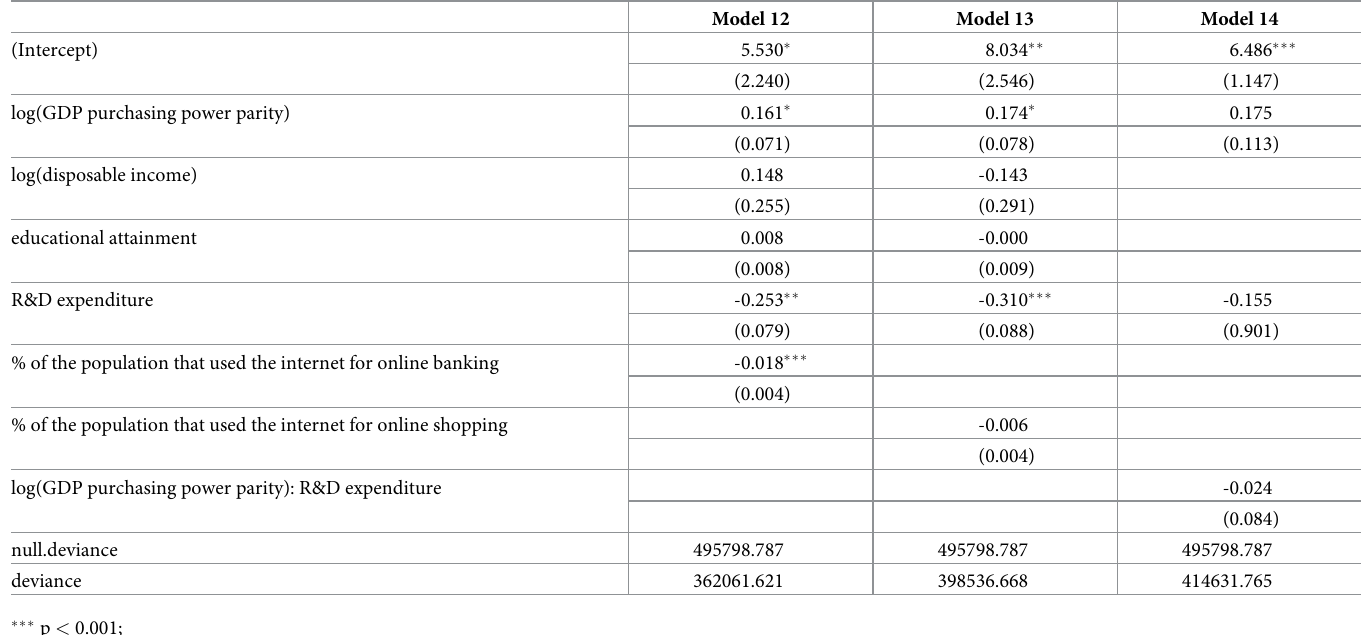
Table 8. European models II. (DV: download per